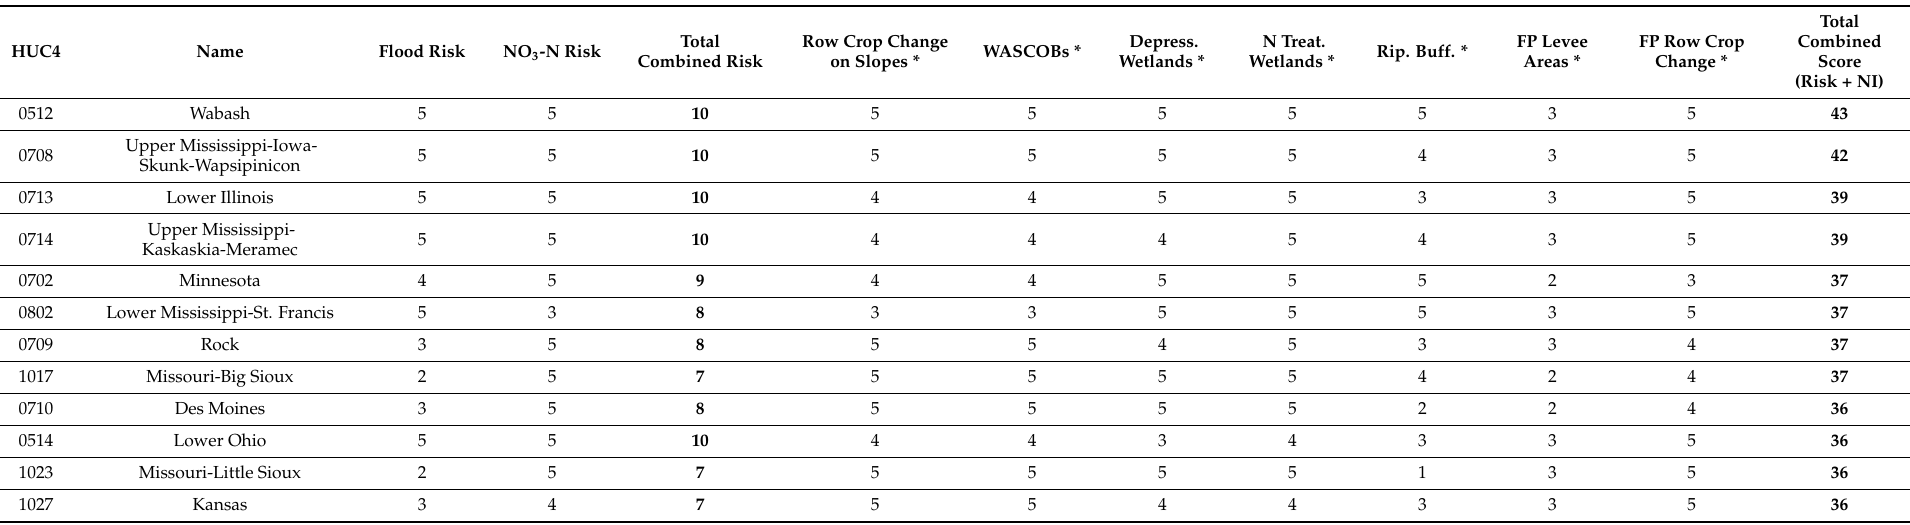
Table 1. Quantile ranking of selected HUC4 basins in MARB for combined flood and N risks and potential NI practice implementation.